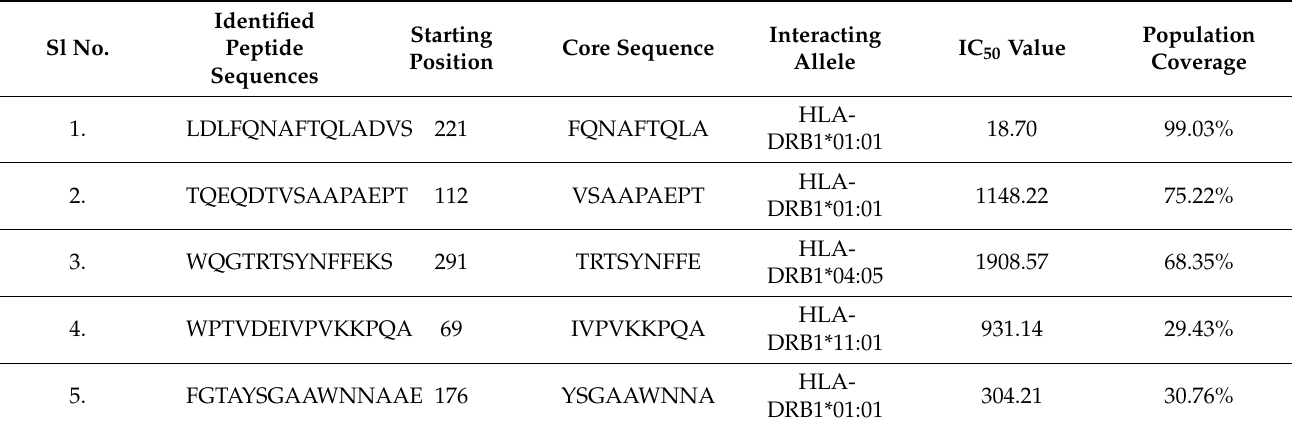
Table 7. Binding affinity and population coverage for the selected peptide sequences from NetMHCI- Ipan.